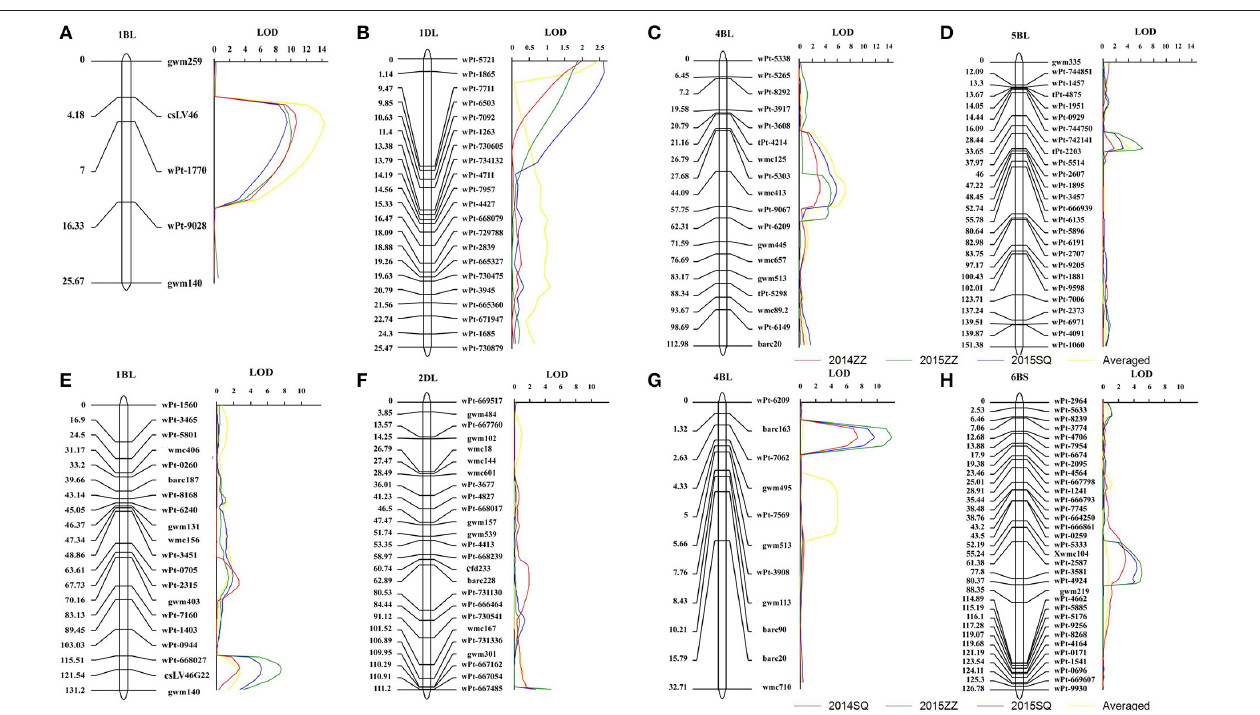
FIGURE 1 | LOD contours for quantitative trait loci (QTL) to powdery mildew on chromosomes 1BL, 1DL, 4BL, and 5BL identified by inclusive composite interval mapping (ICIM) in the Avocet × Francolin#1 population (A–D) , and on chromosomes 1BL, 2DL, 4BL, and 6BS in the Avocet × Quaiu#3 population (E–H) . The significant LOD thresholds were based on 1,000 permutations. Positions (in cM) of molecular markers along chromosomes are shown on the vertical axes using cumulated genetic distances.